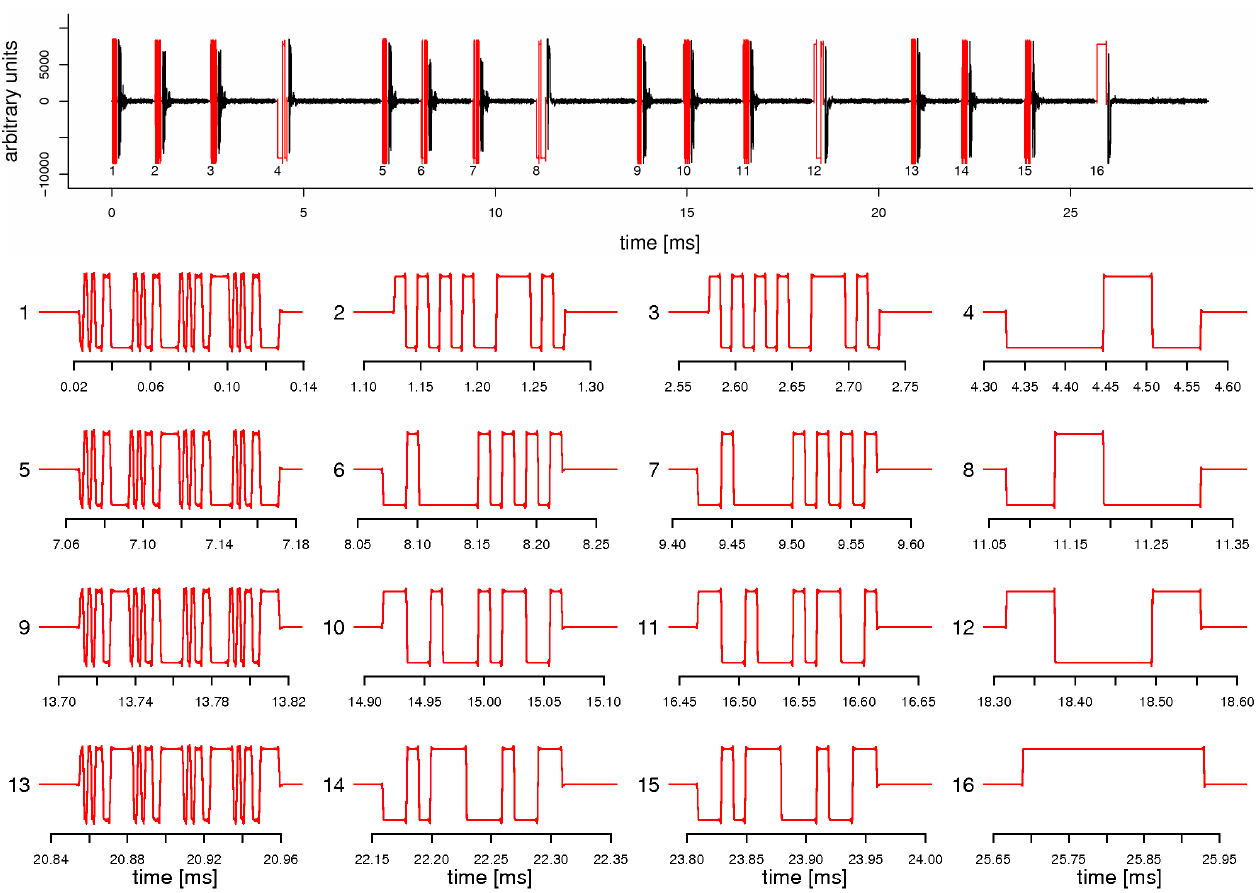
Fig. 2. Top panel: Raw data of a full transmission cycle from experiment 2. Transmission signals are marked with red color. Lower panels: Larger images of the numbered transmission envelopes, notice the differing time